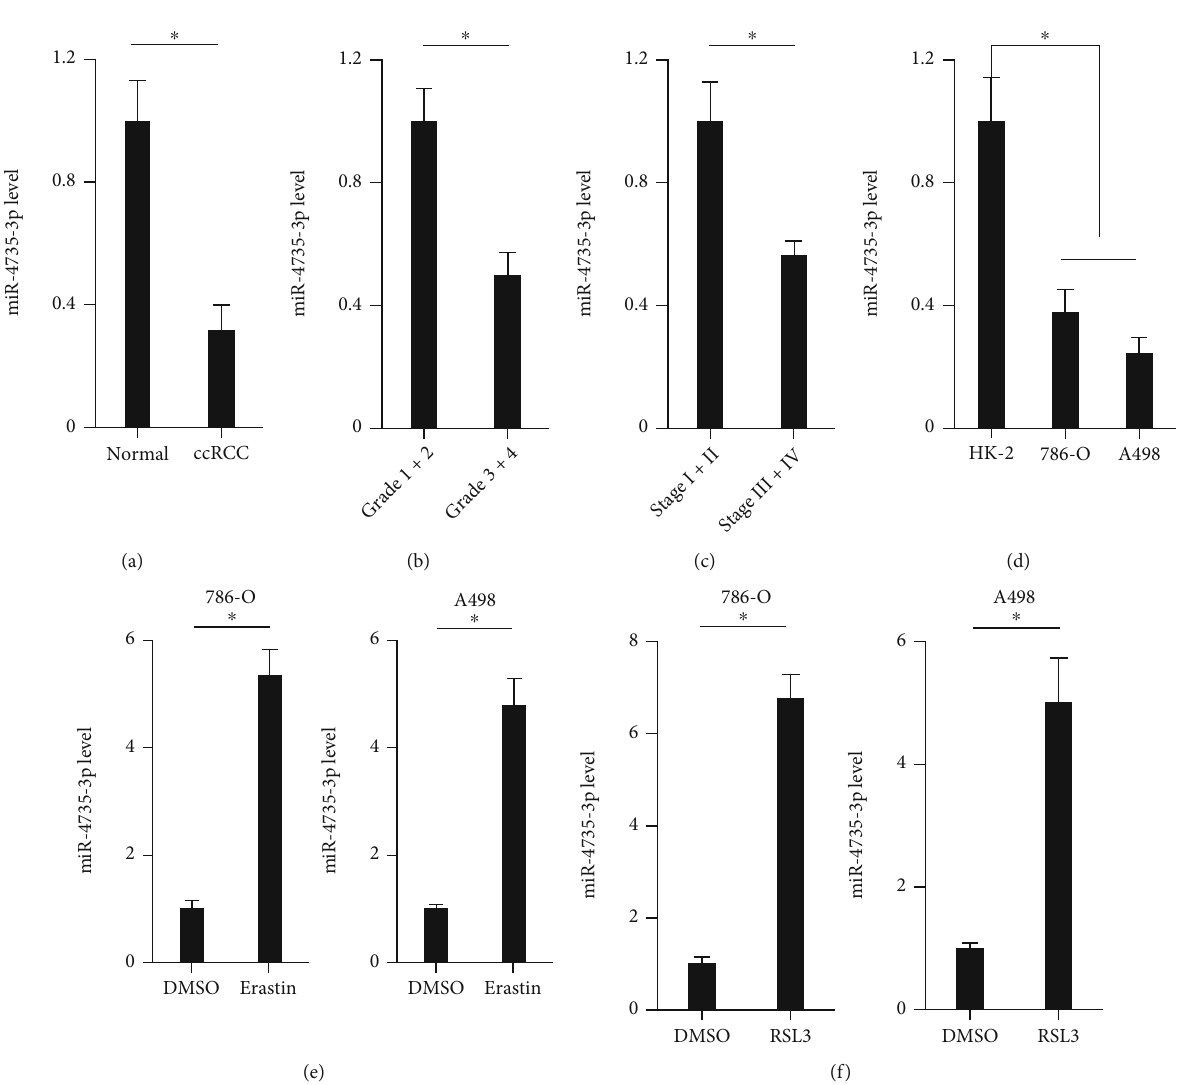
Figure 1: Expression of miR-4735-3p in human ccRCC tissues and cell lines. (a) Relative expression of miR-4735-3p in human ccRCC tissues and adjacent normal tissues. (b) Relative expression of miR-4735-3p in human ccRCC tissues of di ff erent histological grades. (c) Relative expression of miR-4735-3p in human ccRCC tissues of di ff erent clinical TNM stages. (d) Relative expression of miR-4735-3p in human ccRCC cell lines or normal kidney cell line. (e and f) Relative expression of miR-4735-3p in human ccRCC cell lines upon di ff erent ferroptotic stimulations. N = 6 per group. All data were expressed as the mean ± SD ; ∗ P < 0 : 05 was considered signi fi